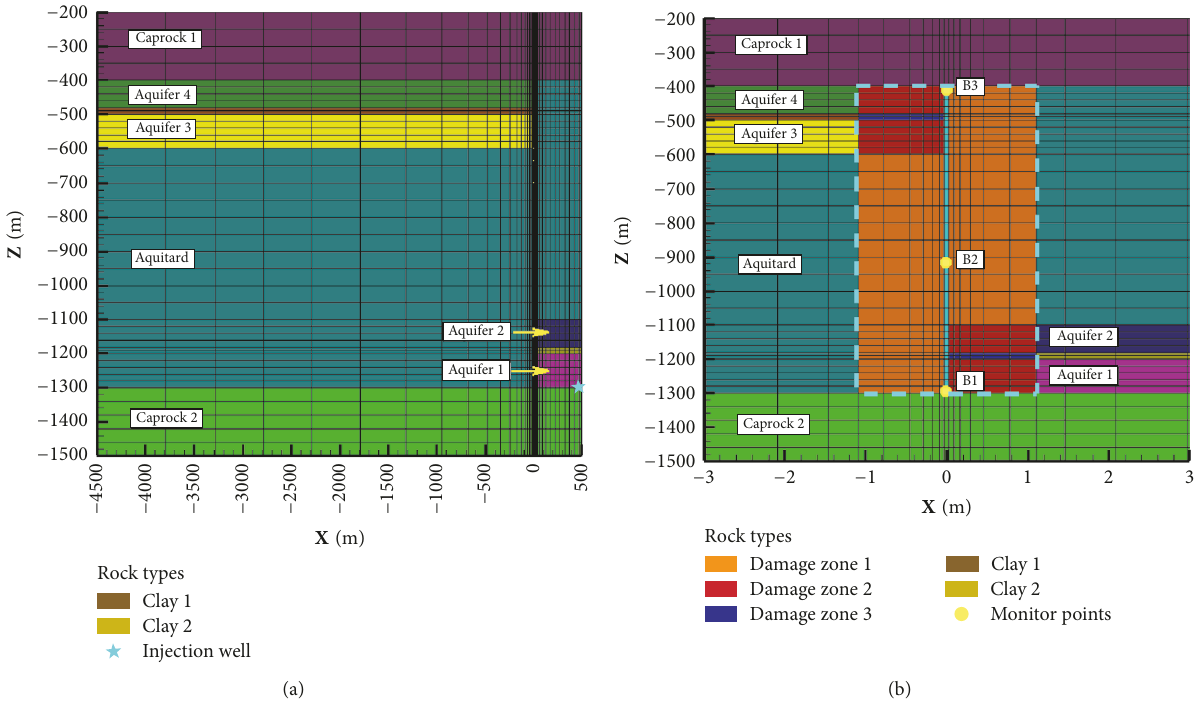
Figure 3: Mesh discretization based on the concept model shown in Figure 1. Picture (a) shows a full view of the grid in which a CO 2 injection well (the cyan star) is located at the right bottom side of Aquifer 1. Picture (b) is the zoom view of the fault zone, comprising a 0.05 m wide fracture zone in the middle and (highlighted by the cyan solid line) several surrounded damage zones of width closing to 1m. The observation points B1, B2, and B3 are located at 𝑍 = − 1290, − 975, and − 410m, respectively ( 𝑋 = 0.0